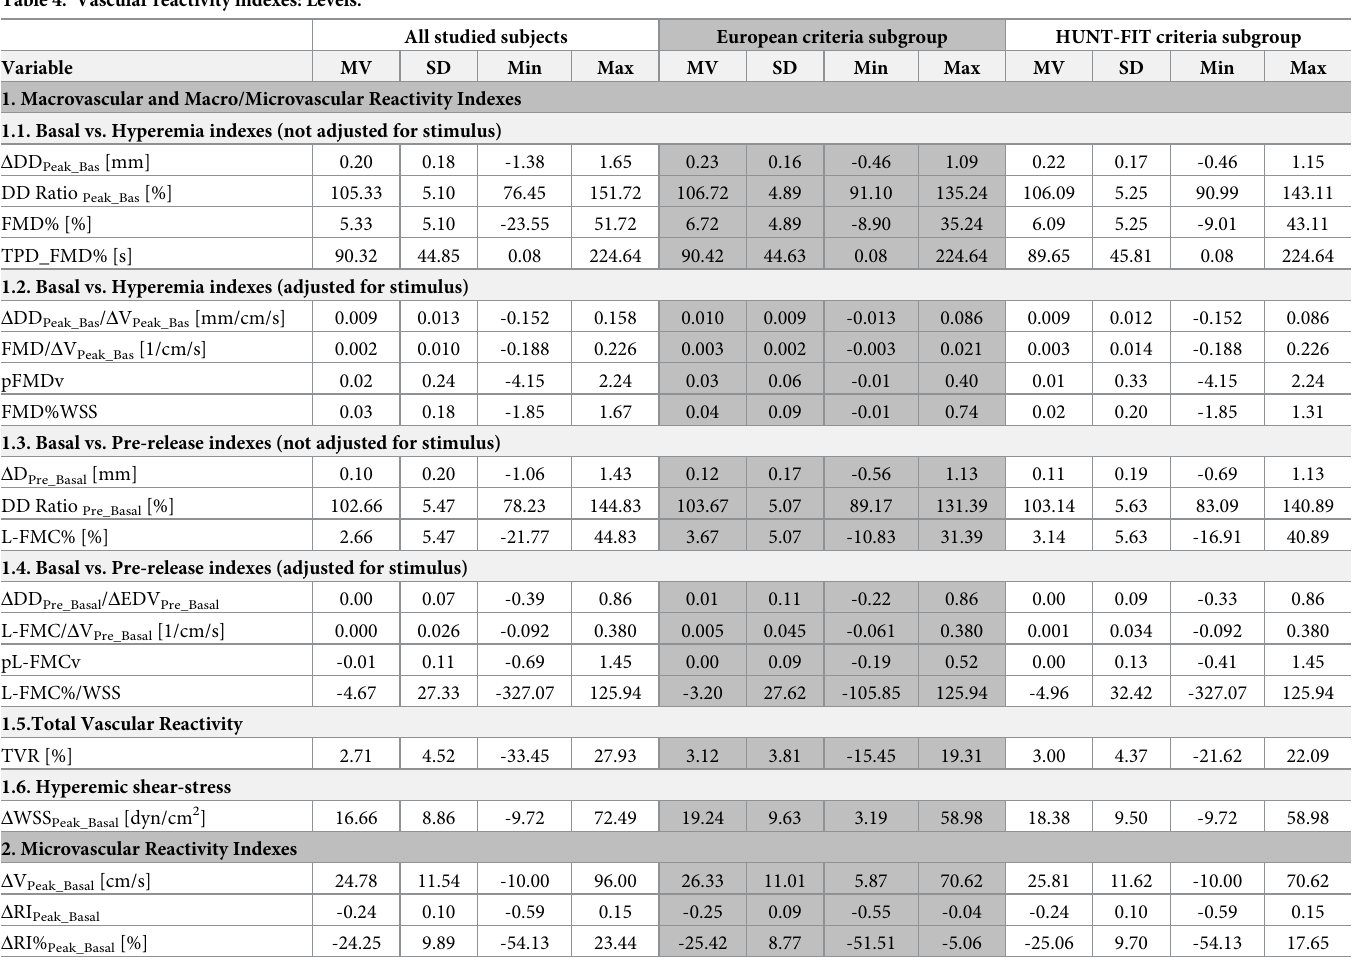
Table 4. Vascular reactivity indexes: